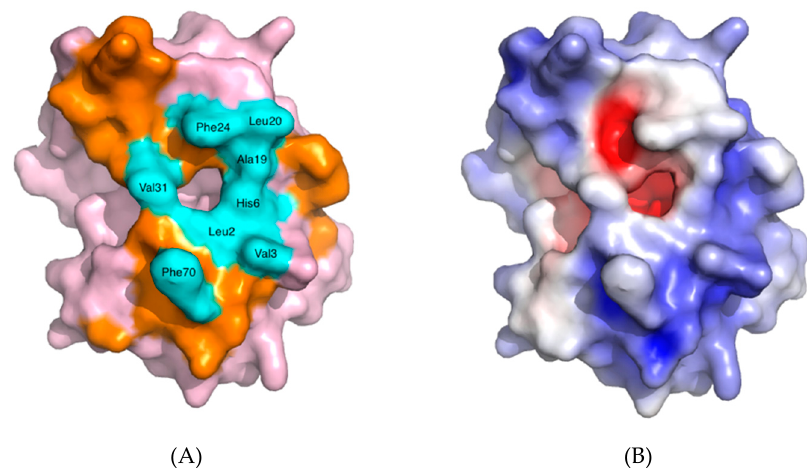
Figure 4. hGIIA shown with space-filling surface: ( A ) The amino acids highlighted in cyan, and identified, form the entrance to the active site, and play a role in interfacial binding by making direct contact with the substrate. The interfacial binding surface (i-face) of hGIIA outside of the amino acids at the entrance to the active site are highlighted in orange; ( B ) Depiction of the electrostatic charge. The high basicity of the protein at the surface is shown by the dominance of blue (positive), over the red of acidity (negative). Confirmation of the non-polar, hydrophobic entrance in orange in the left image is the coincident white of neutrality. The dominance of positive charge is clear. The view 180 ° to this (not shown) has less negative charge again, but does clearly have both a localised hydrophobic patch at the top in the current view and a localised very positive patch relative to the surface shown at the left hand side region near the C-terminus (behind the right hand side in the views given). Figure used PDB ID 3U8B [13] and created with PyMOL using the Adaptive Poisson-Boltzman Solver for the electrostatics [14]. The orientation is the same as used for Figure 2.